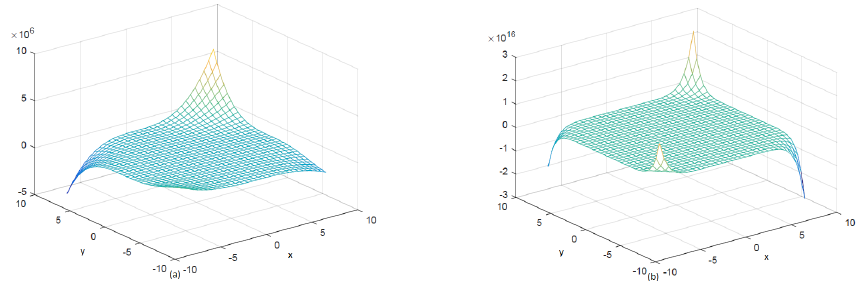
Figure 10: Plotting of (a) M-polynomial and (b) NM-polynomial of Daunorubicin. Corolary 2.9. Let G be the molecular graph of Daunorubicin.